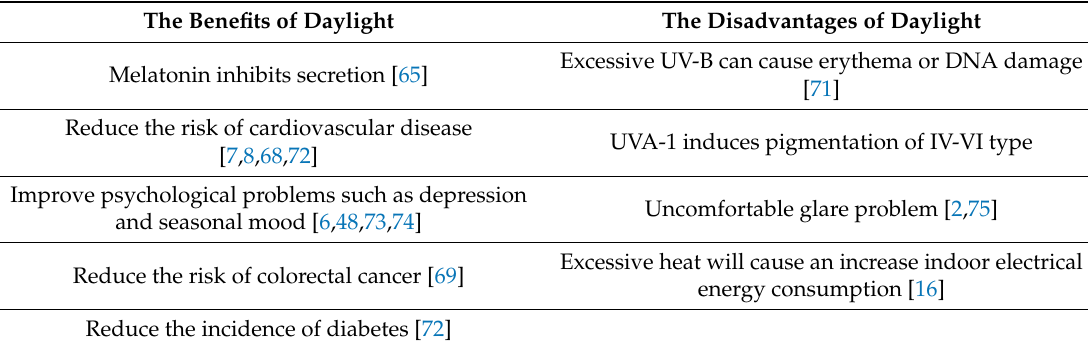
Table 1. The benefits and disadvantages of daylight to the human